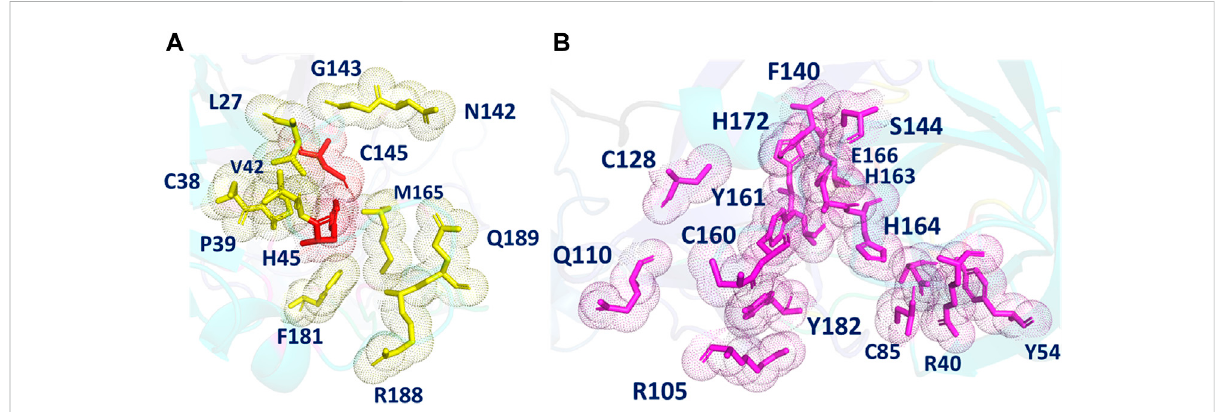
FIGURE 3 (A) The different POOL-predicted pockets for the SARS-CoV-2 Main Protease (PDB ID: 6LU7). The POOL predicted residues in pocket one shown in yellow include the catalytic dyad H41-C145, shown in red. (B) The POOL-predicted secondary recognition pocket, shown in magenta, are the residues surrounding the catalytic dyad.